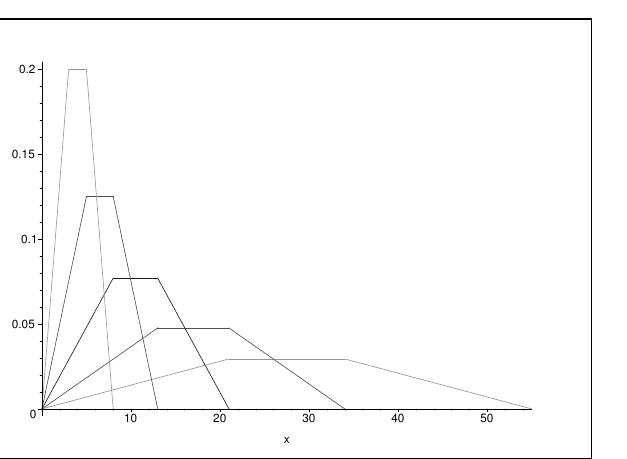
Figure 2 – Graphs of f